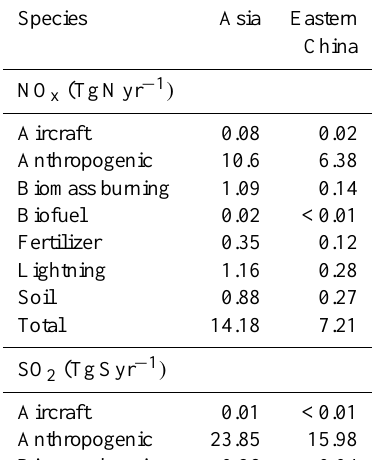
Table 1. Summary of annual emissions of aerosols and aerosol